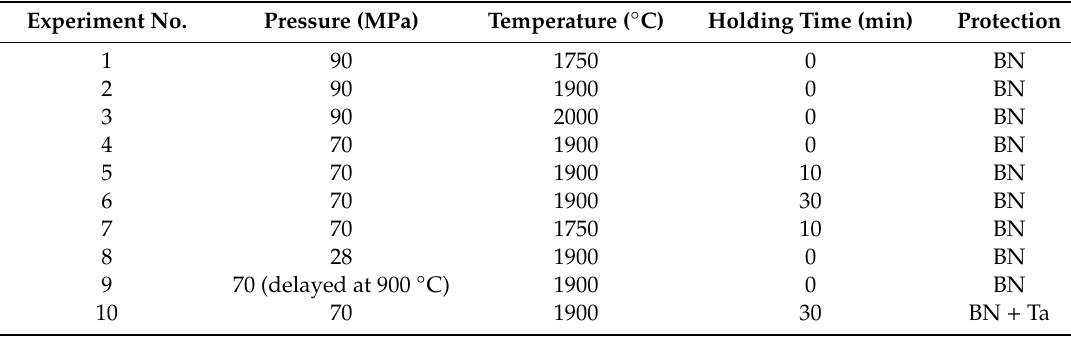
Table 1. Table of sintering conditions of Mo-45 powder. Experiment